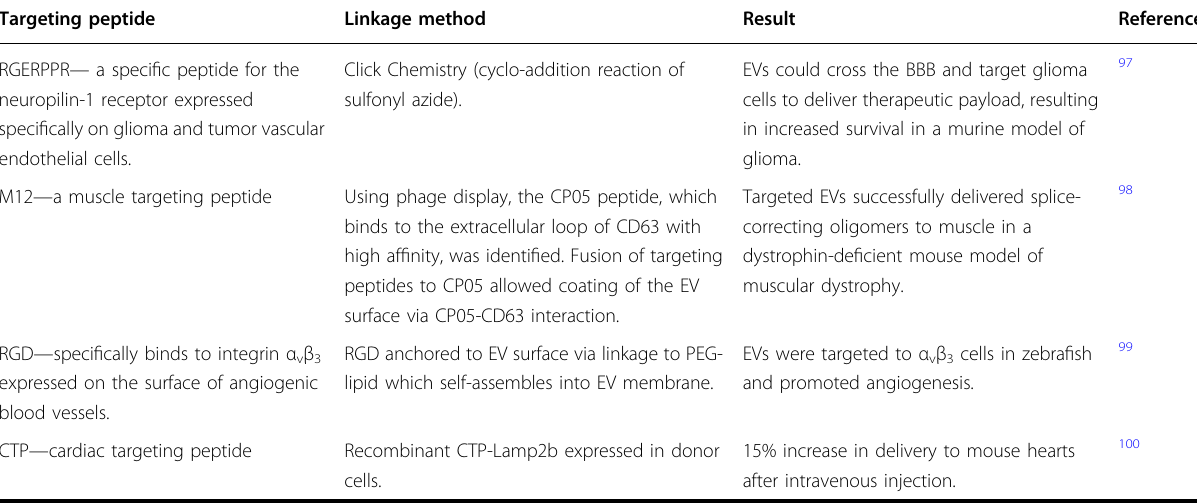
Table 3 Examples of engineering EV targeting by the addition of